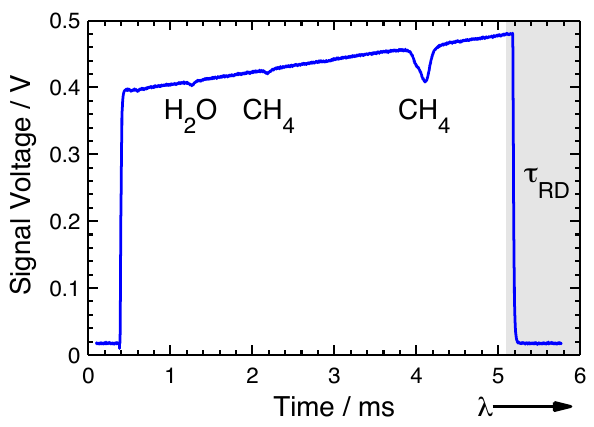
Fig. 4. (a) Sequential measurement of two known calibration gas mixtures (1986.8 ppb, 1794.3 ppb) yielded an accuracy within the 60 minute measurement time of 6.5 ppb ( < 0 . 5% ). Horizon- tal lines indicate the mixing ratio of the respective gas standard as determined by gas chromatography. (b) Difference of average FGGA measurements to gas standard mixing ratio ( (cid:5) 1986.8 ppb; (cid:3) 1794.3 ppb). The accuracy is mostly determined by instrumental drift.